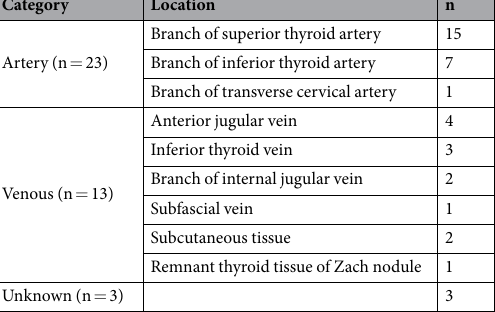
Table 1. Summary of bleeding sources.